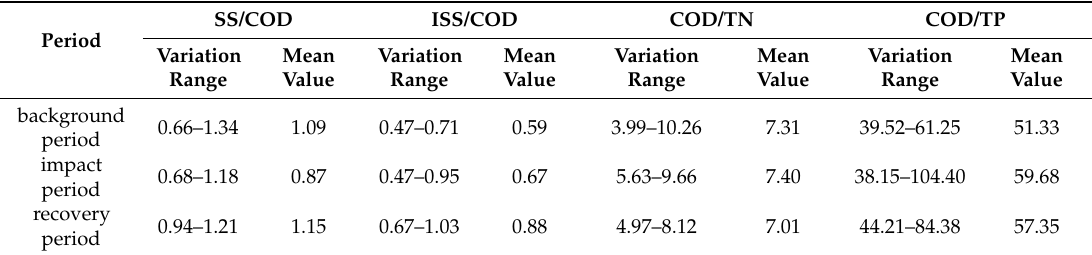
Table 4. SS/COD, ISS/COD, COD/TN, and COD/TP of primary settling tank effluent or AAO influent.